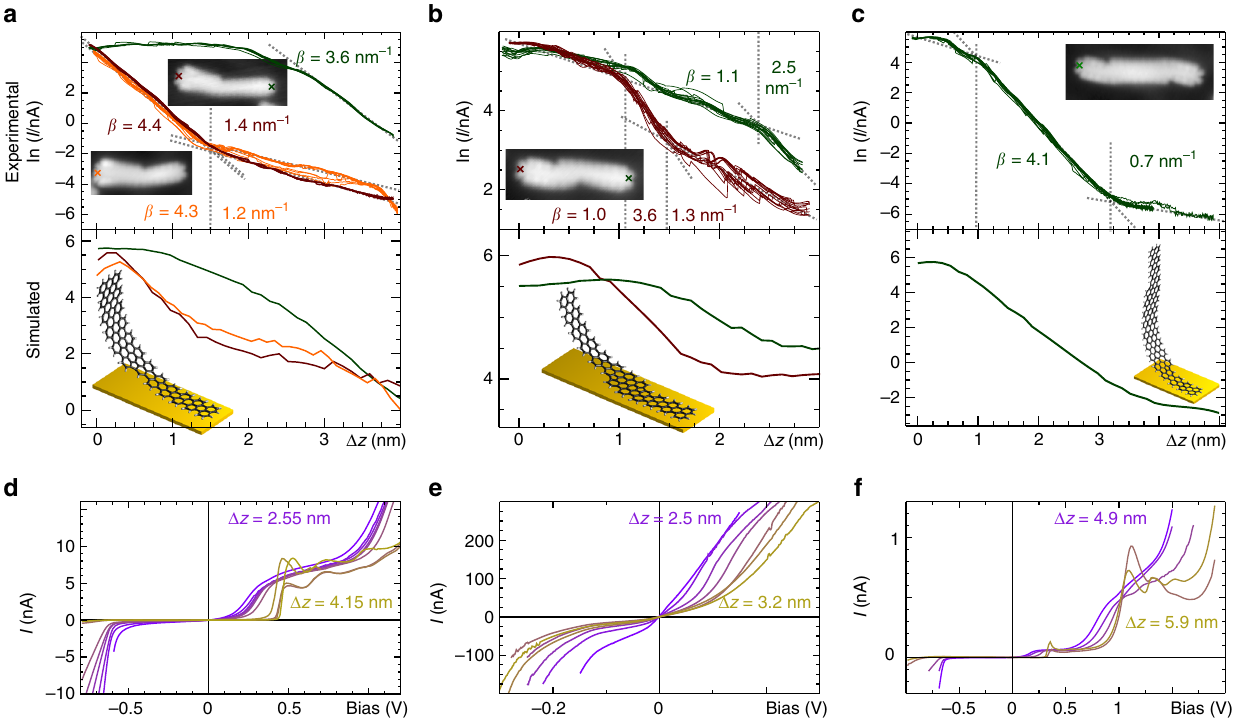
Fig. 5 Conductance measurements of single GNR heterojunctions and heterostructures. a Experimental ( top ) and simulated ( bottom ) ln( I /nA)( Δ z ) curves obtained while lifting the 5/7-GNR(3,3) from the 7-GNR side ( orange ) and while lifting the 5/7-GNR(4,3) from the 5-GNR side ( green ) and 7-GNR side ( red ). The insets in the top fi gure show STM topographs of the respective ribbons ( V = 0.1 V, I = 40 pA) with tip position for lifting experiment indicated by crosses, whereas the inset in the bottom image shows a calculated lifting geometry of the 5/7-GNR(3,3). b Same as a , but for lifting a 5/7/5-GNR(2,1,3) from the long 5-GNR side ( green ) and the short 5-GNR side ( red ). c Same as a , but for lifting a 5/7/5-GNR(2,4,2). d – f Experimental I ( V ) curves recorded with increasing tip heights Δ z for 5/7-GNR(3,3) and 5/7/5-GNR(2,1,3) and 5/7/5-GNR(2,4,2) heterojunctions,